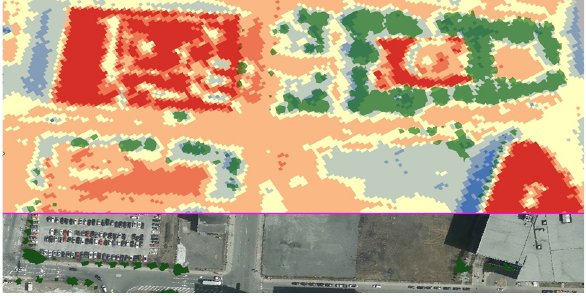
Figure 7. Map shows thermal behavior for different sites covered with asphalt, grass, or woodlands Variability is observed in relation to the exposure of the sites (shadowlit versus sunlit). The contribution of 3D geospatial data from Ville de Montreal also allows the visualization of thermal data on the ground surface and the roofs of buildings.